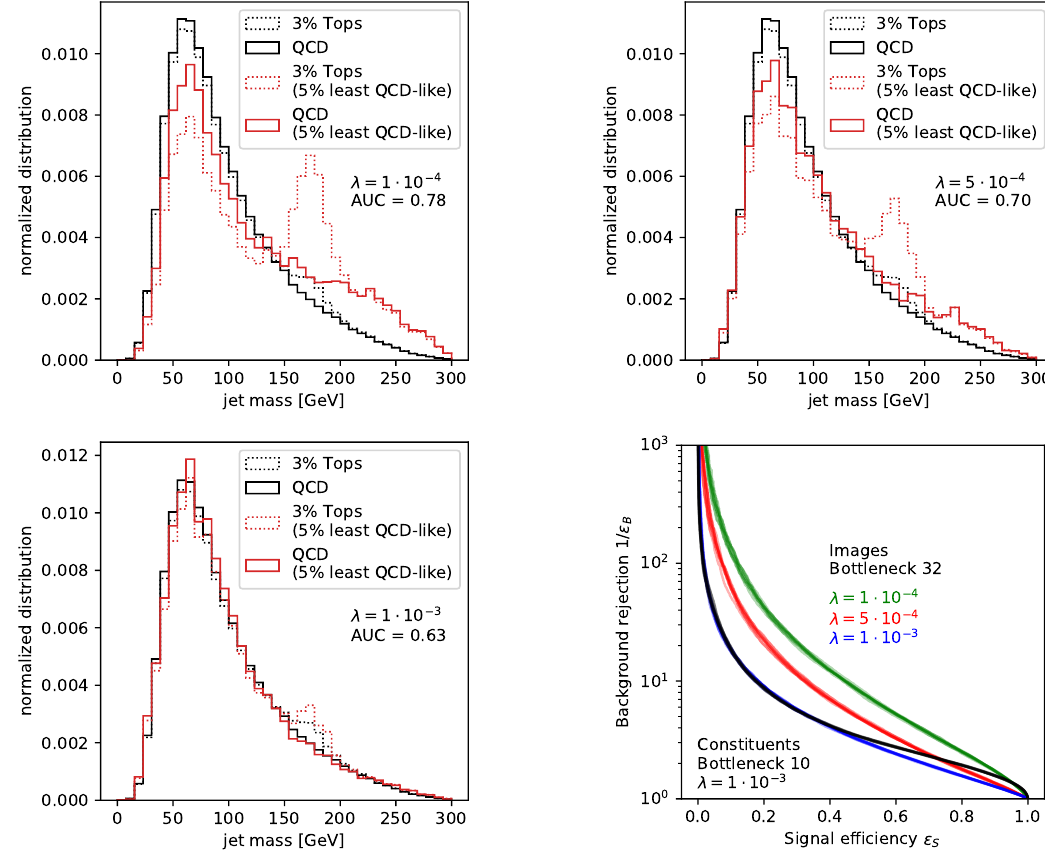
Figure 6: First three panels: jet mass distributions from the adversarial autoencoder with different values for λ , trained on pure QCD, and tested on pure QCD and a sample with 3% top jets. Lower right: ROC curves for the image-based and 4-vector- based adversarial autoencoders. The widths of the lines show the variation based on ten independent test samples for fixed